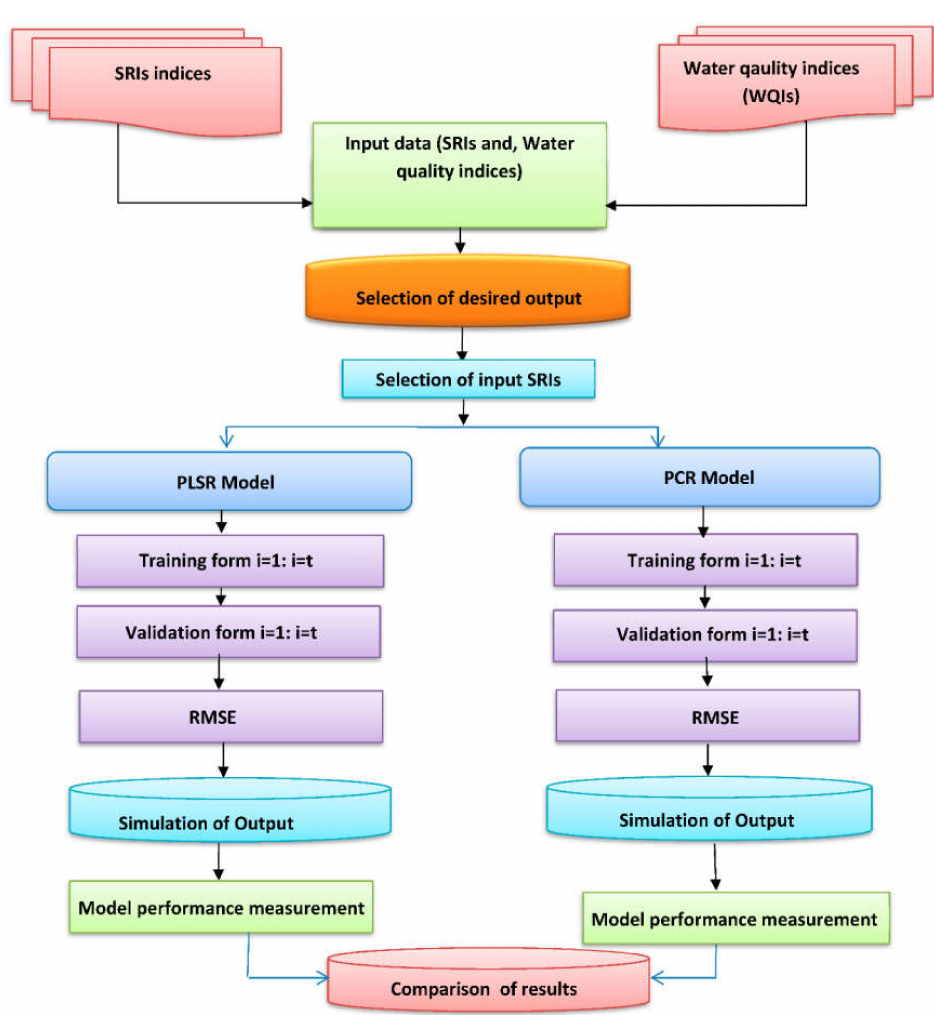
Figure 5. Schematic flowchart of the process of PLSR and PCR used to assess DWQI, TDS, HPI, and C d of water samples in this